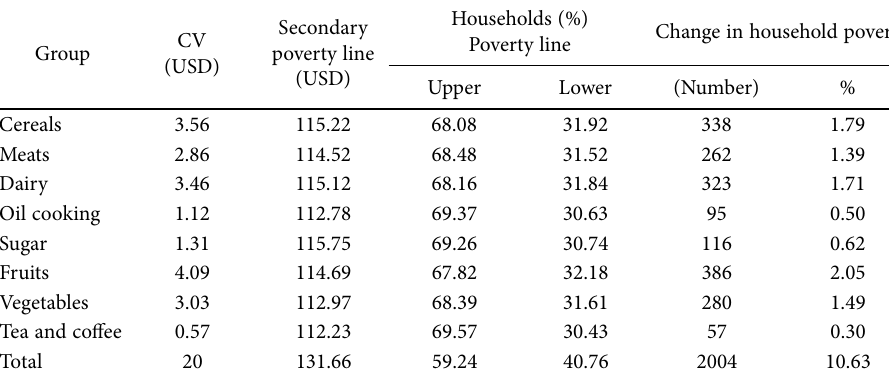
Table 6. The impact of rising food prices on the poverty.